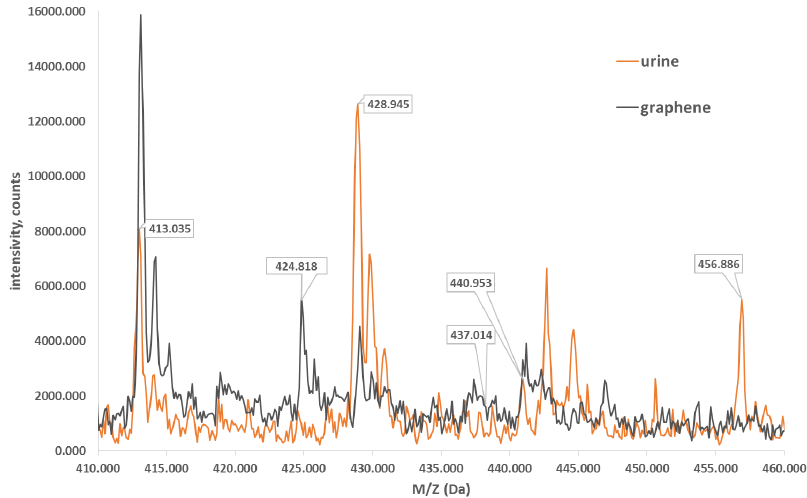
Fig. 7. Fragments of MALDI spectra (matrix THAP) of GO and urine fraction 8.5 min in the region M / Z 410 – 460 Da.